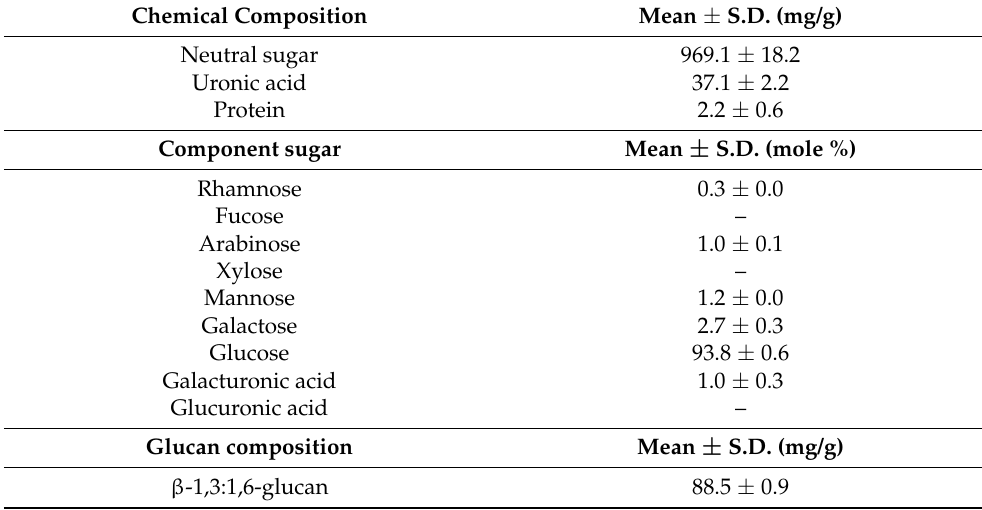
Table 2. Chemical components, sugar, and glucan composition of